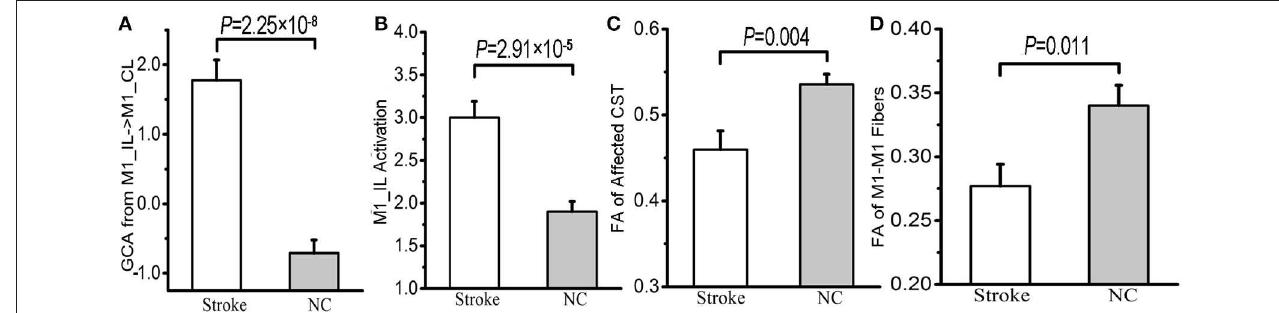
FIGURE 3 | Differences in the effective connectivity from ipsilesional to contralesional M1 (A) , the activation of ipsilesional M1 (B) , the FA values of the affected CST (C) and M1-M1 anatomical connection (D) between stroke patients and normal controls. BOLD, blood oxygen-level dependent; CL, contralesional; CST, corticospinal tract; FA, fractional anisotropy; GCA, Granger causality analysis; IL, ipsilesional; M1, primary motor cortex; and NC, normal control.